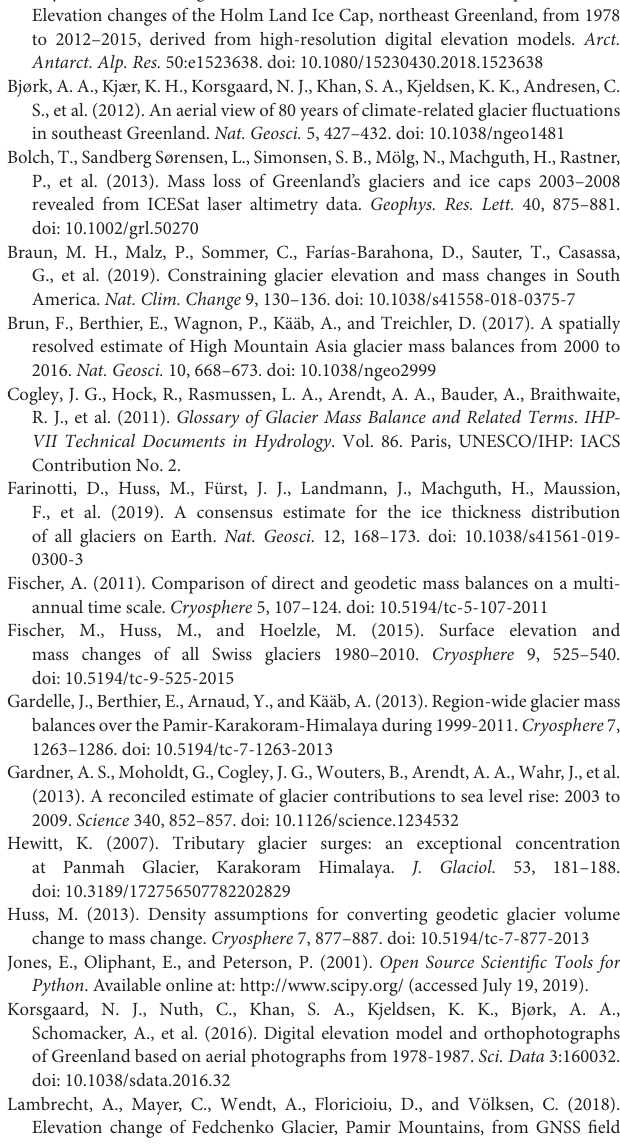
measurements and TanDEM-X elevation models, with a focus on the upper glacier. J. Glaciol. 64, 637–648. doi: 10.1017/jog.2018.52 Le Bris, R., and Paul, F. (2015). Glacier-specific elevation changes in parts of western Alaska. Ann. Glaciol. 56, 184–192. doi: